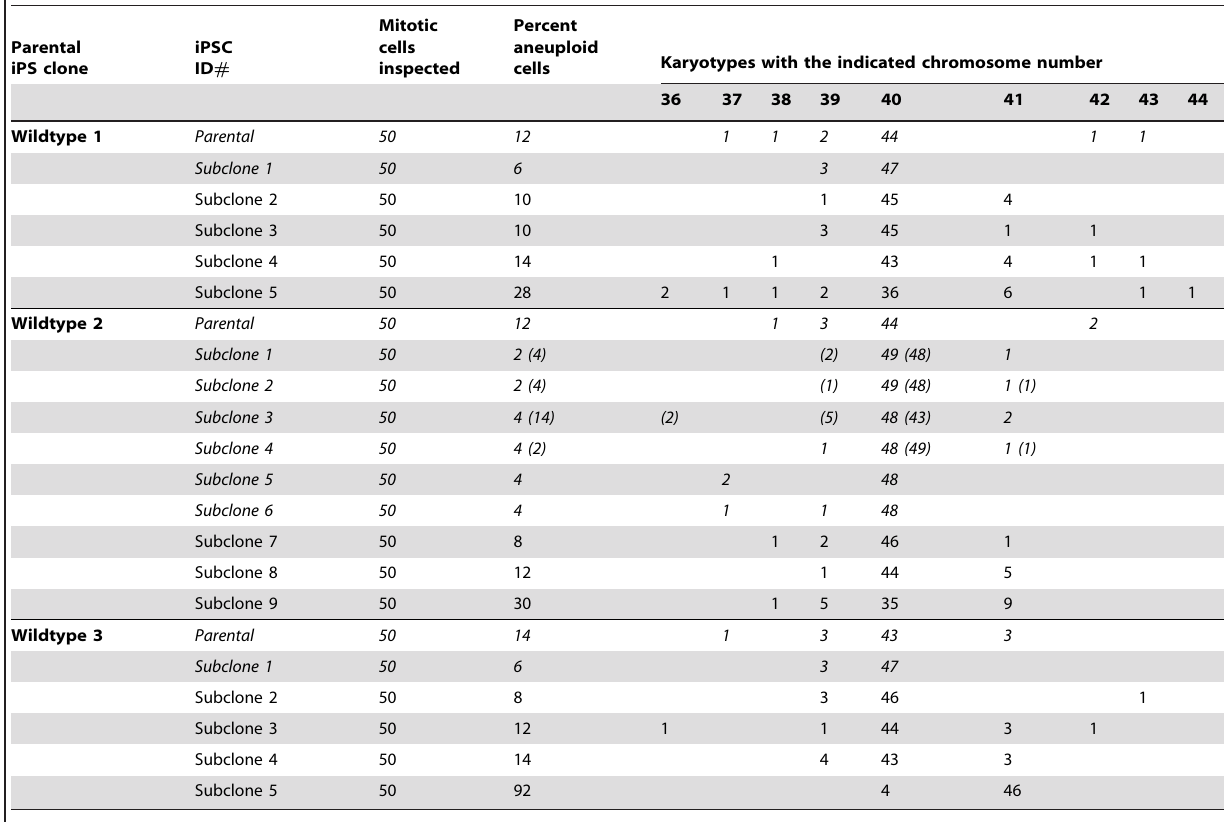
Table 4. Subcloning can reduce aneuploidy rates of iPSC